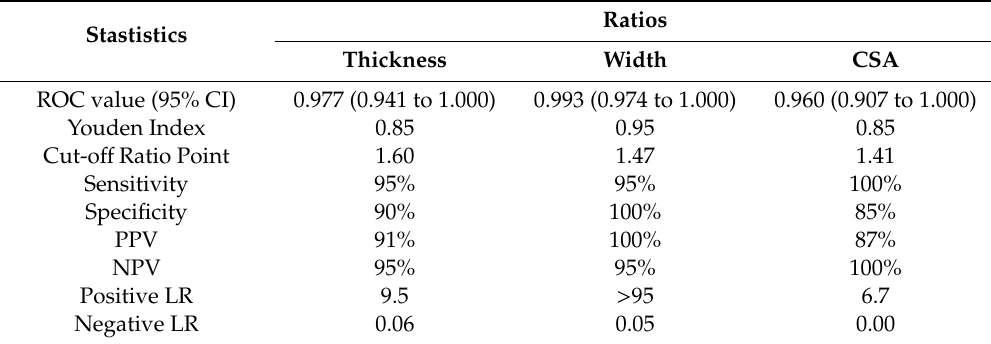
Table 4. Validity of ultrasound measurement ratios for discrimination between painful versus non-painful knees in non-elite sport players with unilateral patellar